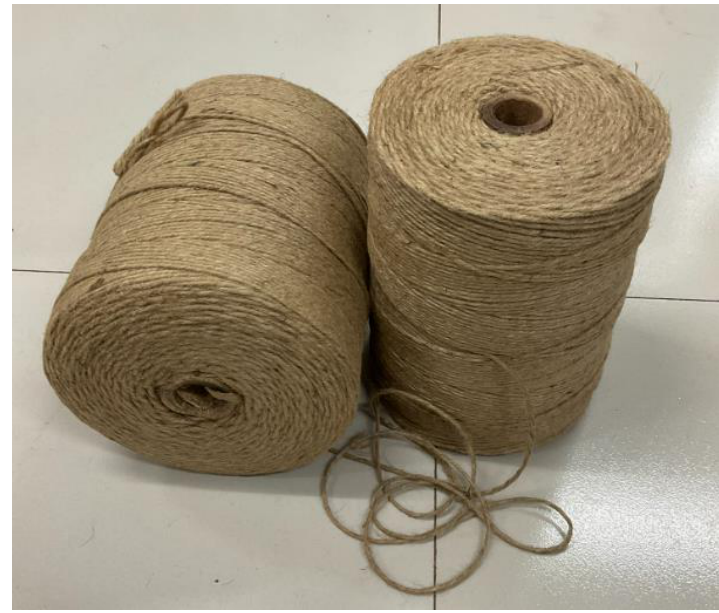
Figure 2. Hemp fiber rope.